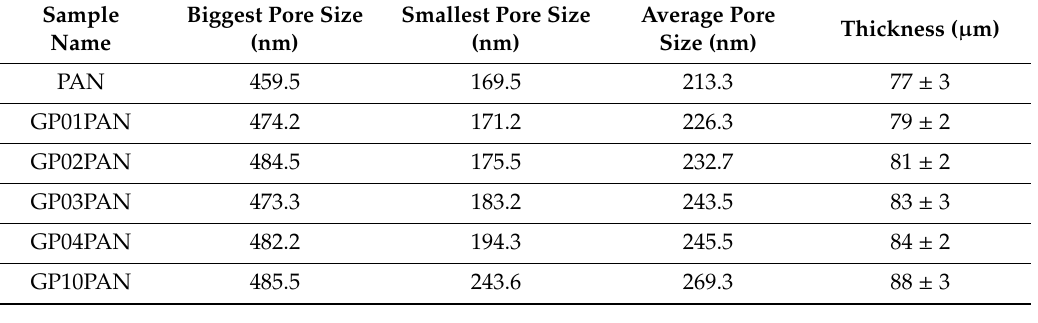
Pore size and thickness of polyacrylonitrile (PAN), graphene oxide modified by polydiallyldimethylammonium chloride / polyacrylonitrile (GP / PAN) nanofiber membranes.